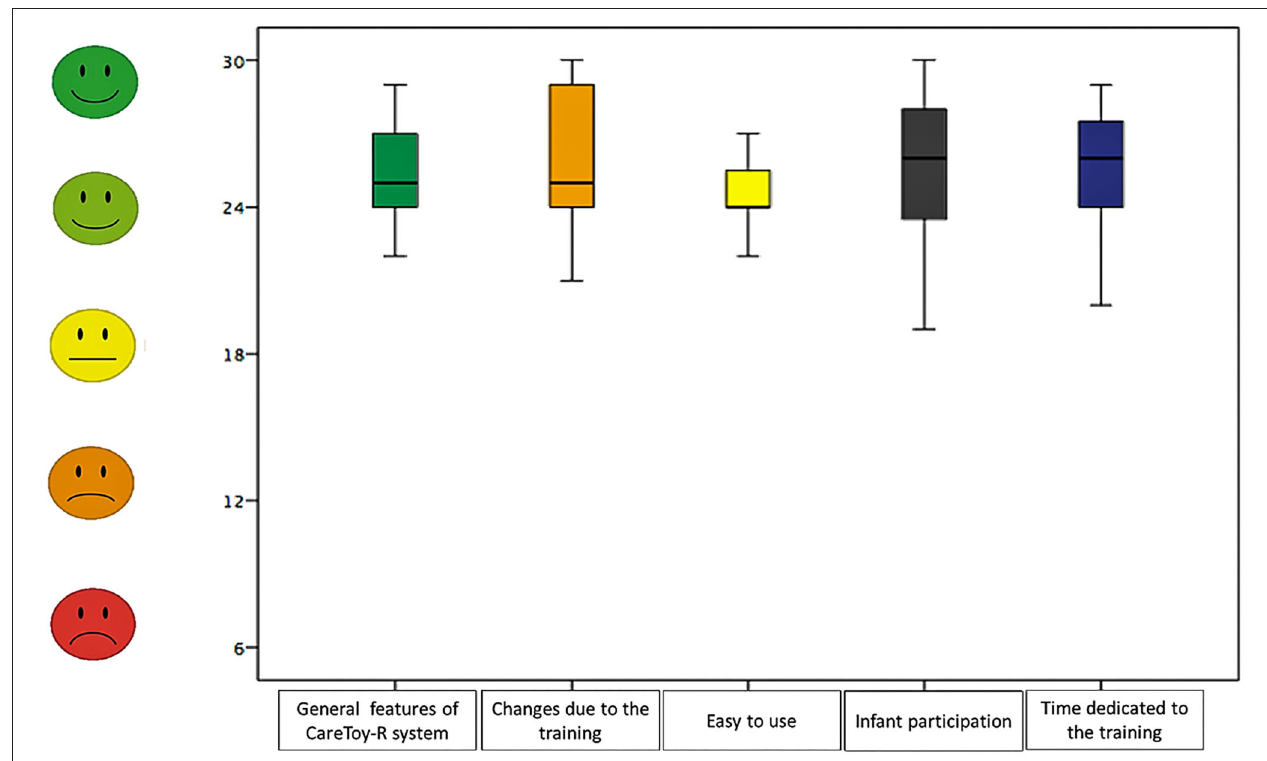
FIGURE 3 | Answers of CRQPE